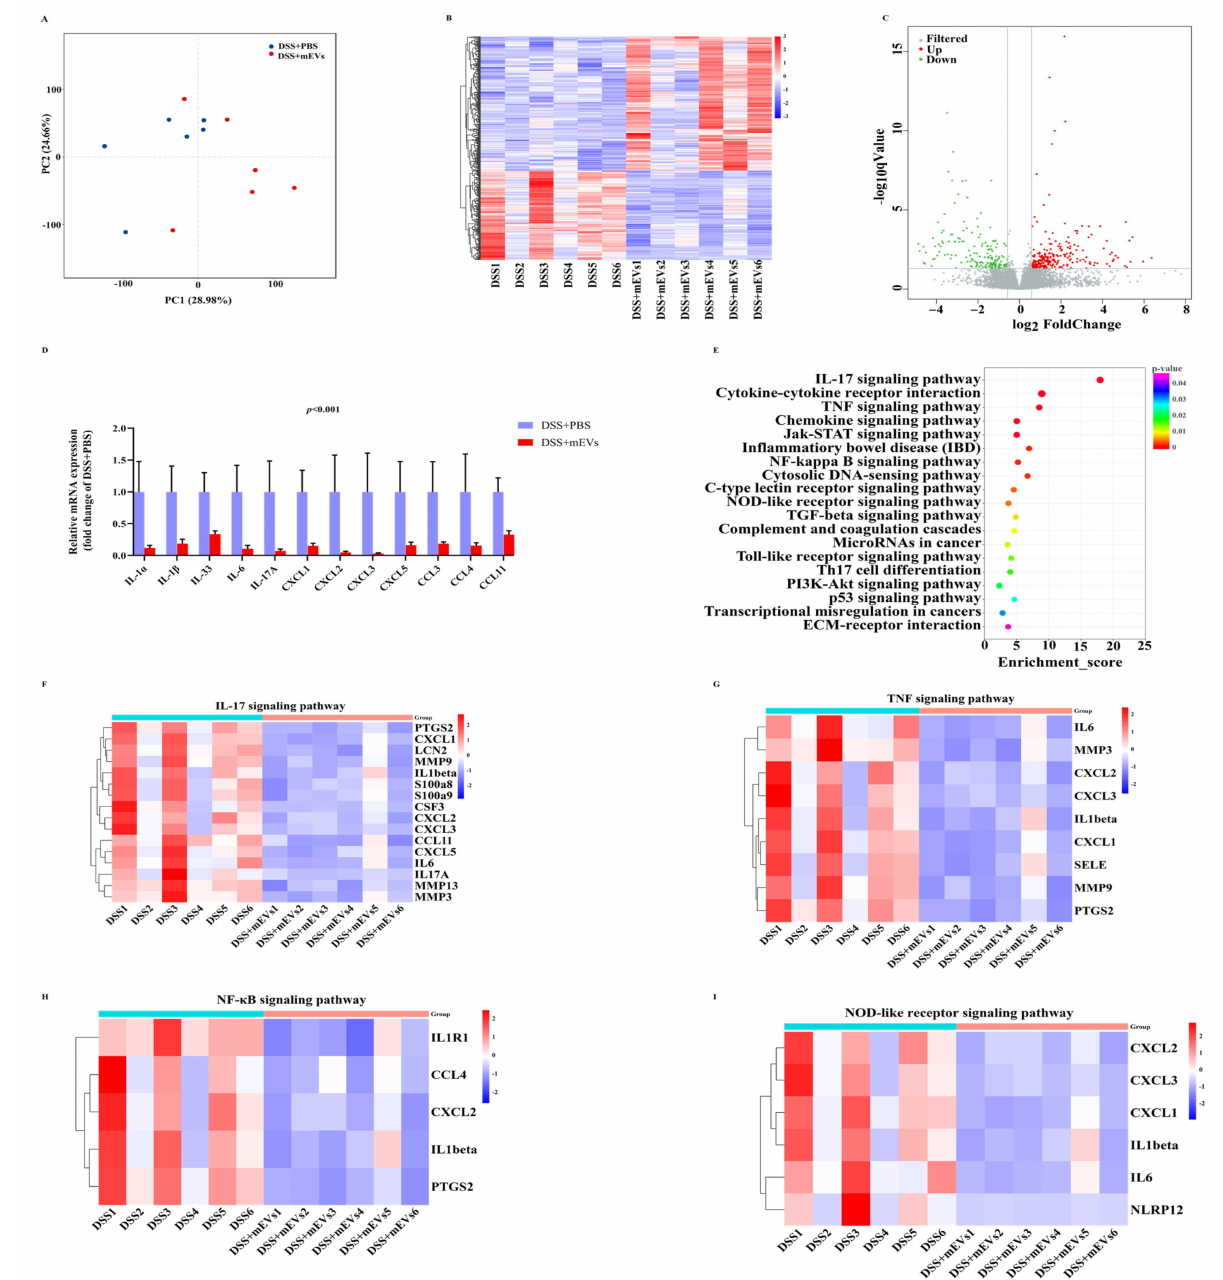
Figure 3. mEVs altered colonic gene expression in DSS-induced colitis. ( A ) Principle component analysis (PCA) of the gene expression profiling in the colonic tissues. ( B ) Heatmap of hierarchical clustering for the transcriptional profiling in the 12 colonic tissues. ( C ) Volcano plot of the alteration of colonic genes in response to mEVs (FC > 1.5/FC < 0.67, FDR < 0.05). ( D ) The relative abundance levels of partial inflammatory factors according to transcriptomic analysis. ( E ) KEGG pathway enrichment analysis of the most significantly down-regulated pathways. ( F – I ) Heatmap of the inflammation-related pathways enriched in the significantly down-regulated